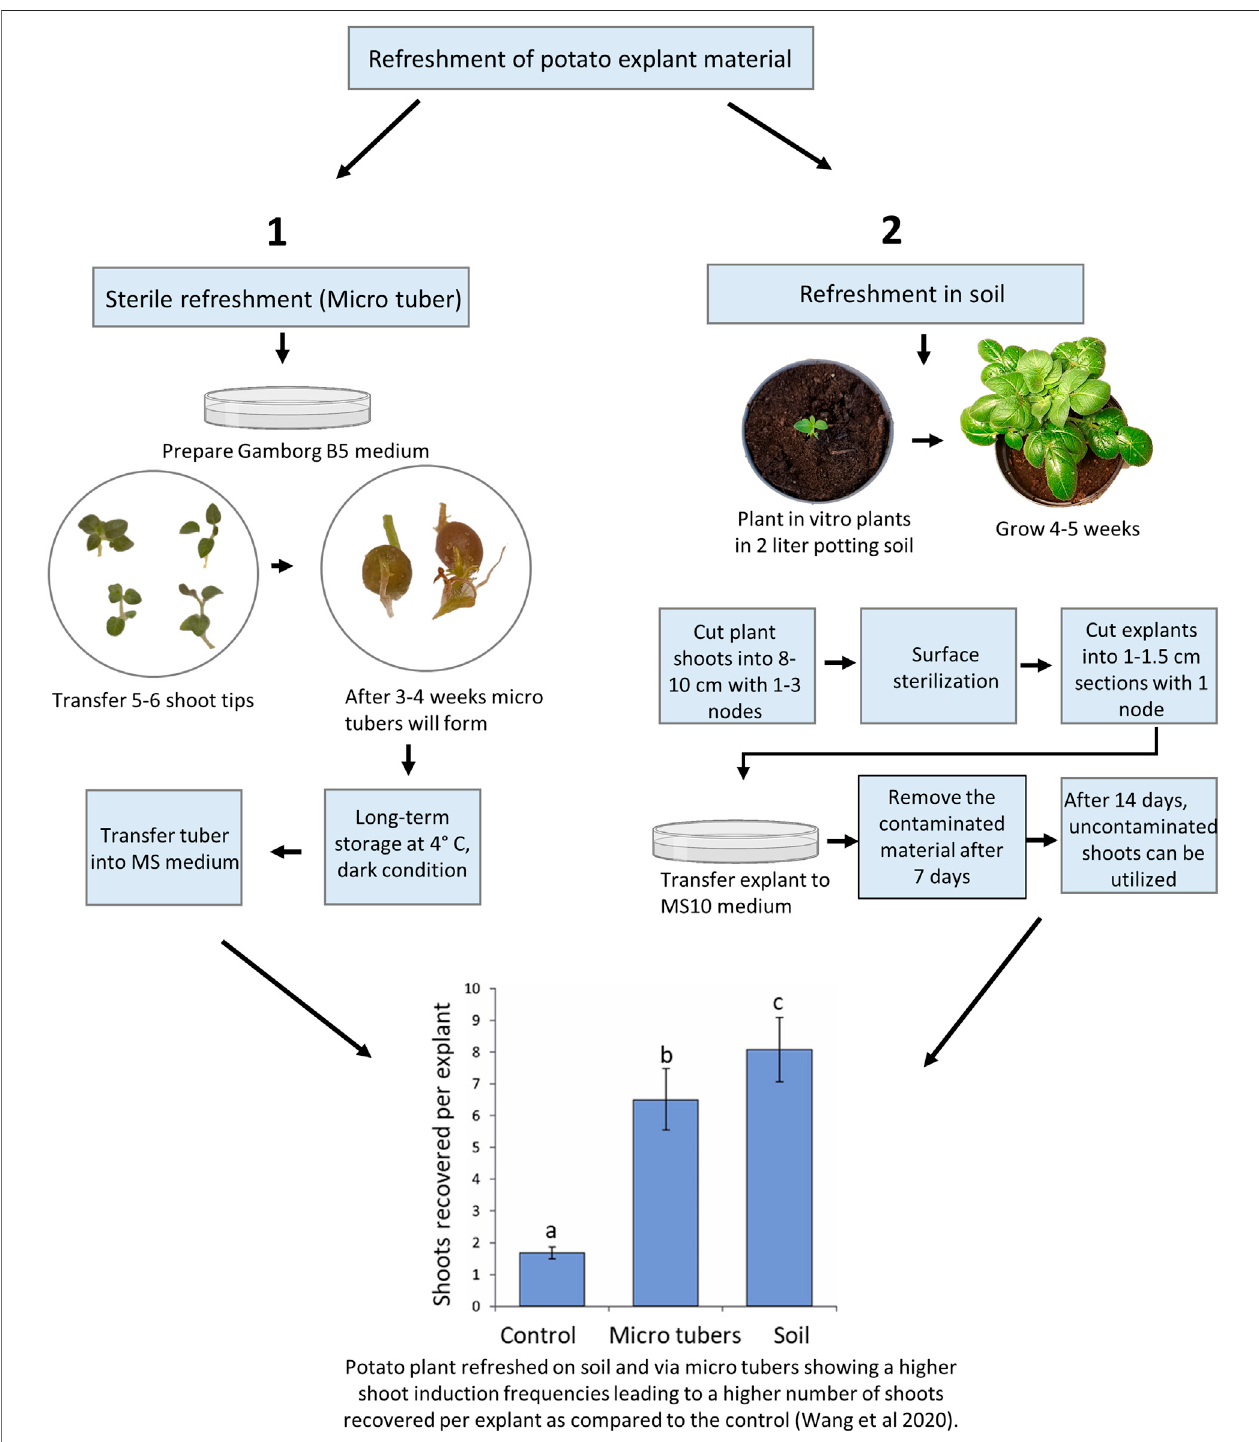
FIGURE1| Overviewofpotatomaterialrefreshment. Thetreatments denotedbydifferentlowercaselettersindicatedasigni fi cantdifferenceat p < 0.05byTukey ’ s HonestSigni fi cantDifferencetest.Theapicalportionofcontrollineswasculturedevery3 – 4weeksonstandardMurashigeandSkoog(MS)mediaplus0.01 mg/lIBAand kept at 20 ° C, 16 h photoperiod with 40 – 60 μ mol/m 2 /s. A total of sixty explants from approximately 10 in vitro plants were observed for each treatment, and the experiments were repeated twice.